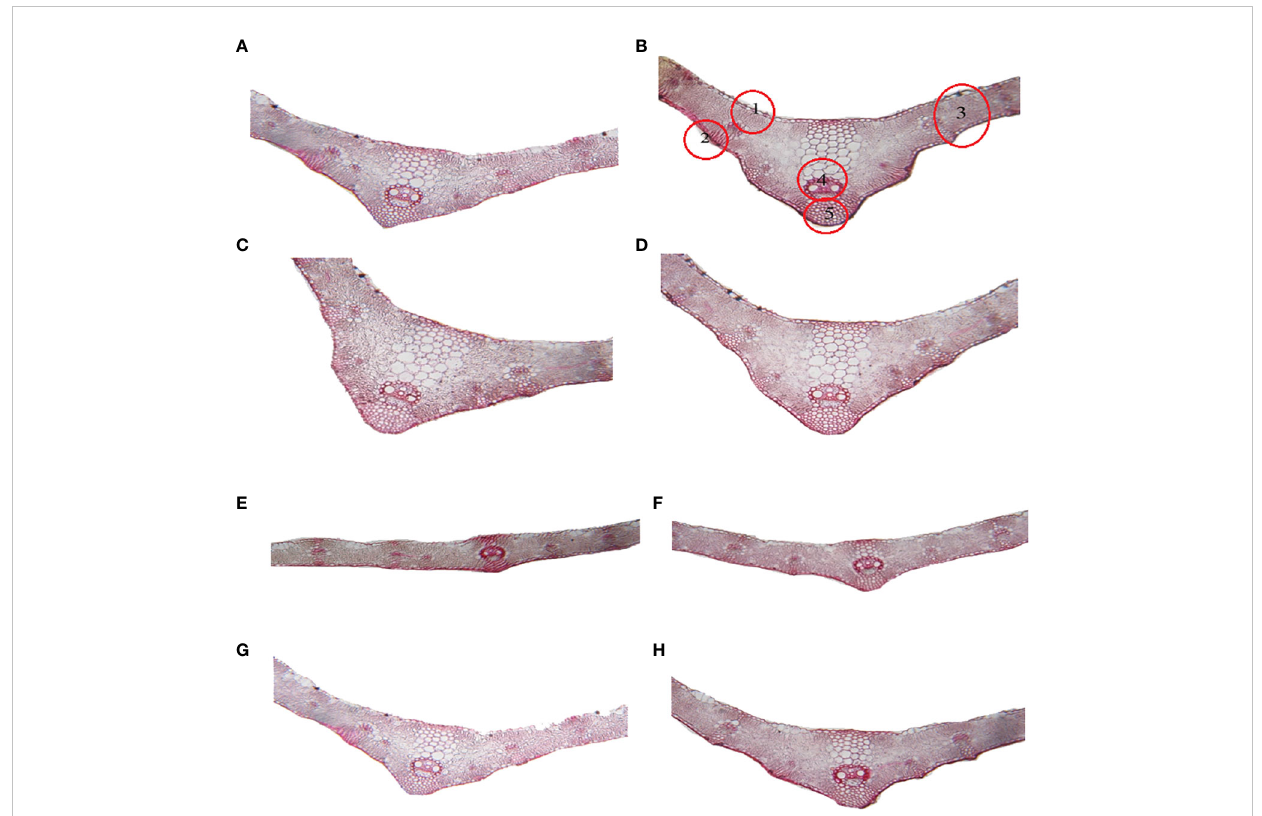
FIGURE 4 Transverse sections in the fl ag leaf blade on the main wheat stem as affected by foliar application of silymarin (Sm), clove fruit extract (CFE), or silymarin-enriched clove fruit extract (CFE-Sm) under Cd stress. (A) control, (B) treated with Sm, (C) treated with CFE, (D) treated with CFE-Sm, (E) treated with Cd, (F) treated with Sm + Cd, (G) treated with CFE + Cd, (H) treated with CFE-Sm + C1: Upper Epidermis, 2: Lower Epidermis, 3: Mesophyll tissue, 4: Vascular bundle of midvein, 5: Schalaranchyma